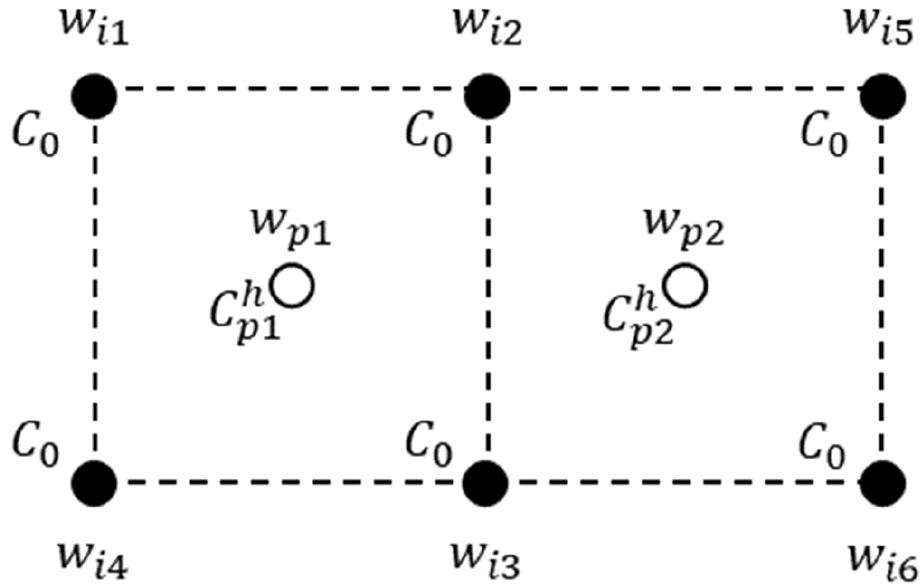
Figure 1. The schematic diagram of the calculation principle for the “flow ratio of groundwater” in two pumping-injection units.